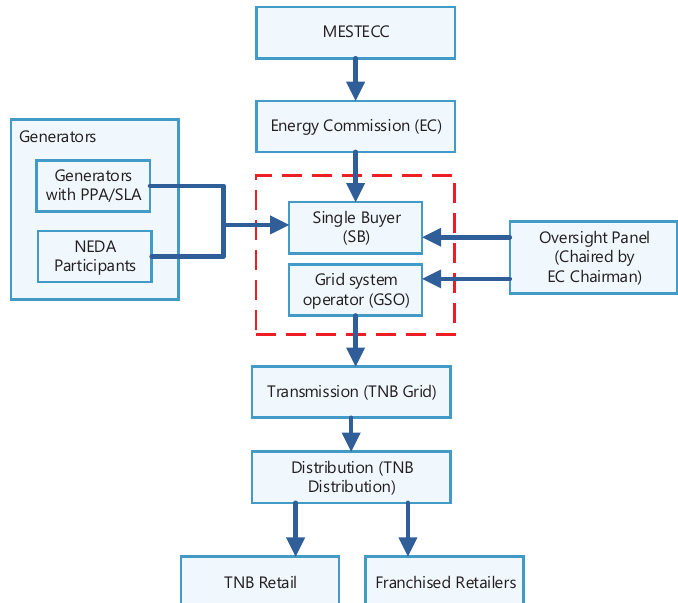
Figure 5. The current MESI